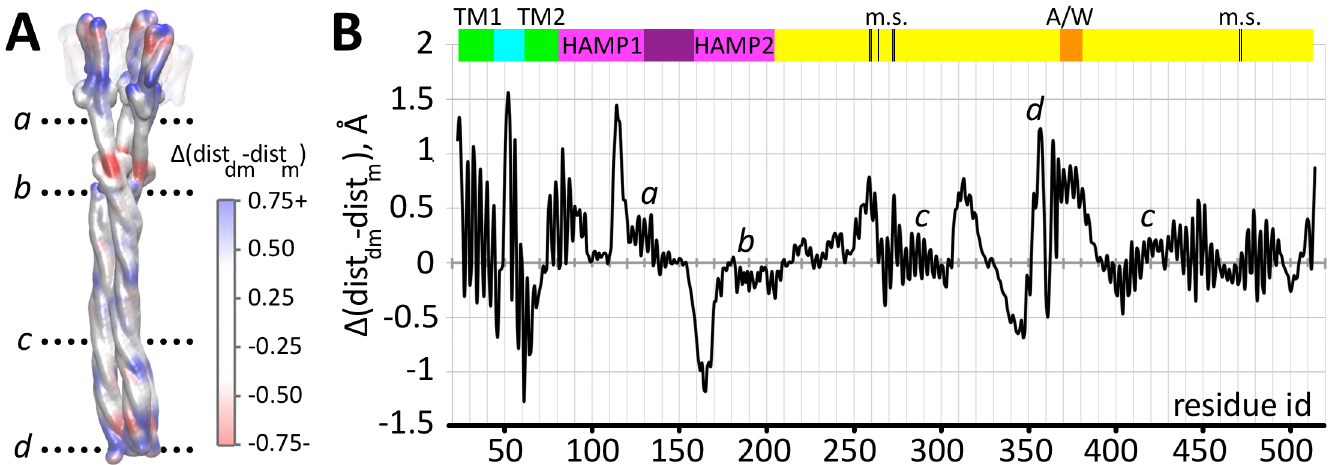
Fig 3. Intra-dimer distance changes between related residues of the transducer upon demethylation A: Structure of the Np SRII/ Np HtrII trimeric complex with distance changes color coded (calculated as an average over the three dimers). Positive values of the distance difference (blue) indicate a looser packing of the corresponding residues in the demethylated system, negative values (red) indicate a more compact packing. B: The intra-dimer distance difference as function of residue number shows distinct changes in the transmembrane region of the complex, an inversion of the packing densities for the two HAMP domains, minor changes at the methylation sites (m.s.), and a decrease of the packing density in the CheA/CheW binding site region labeled A/W.